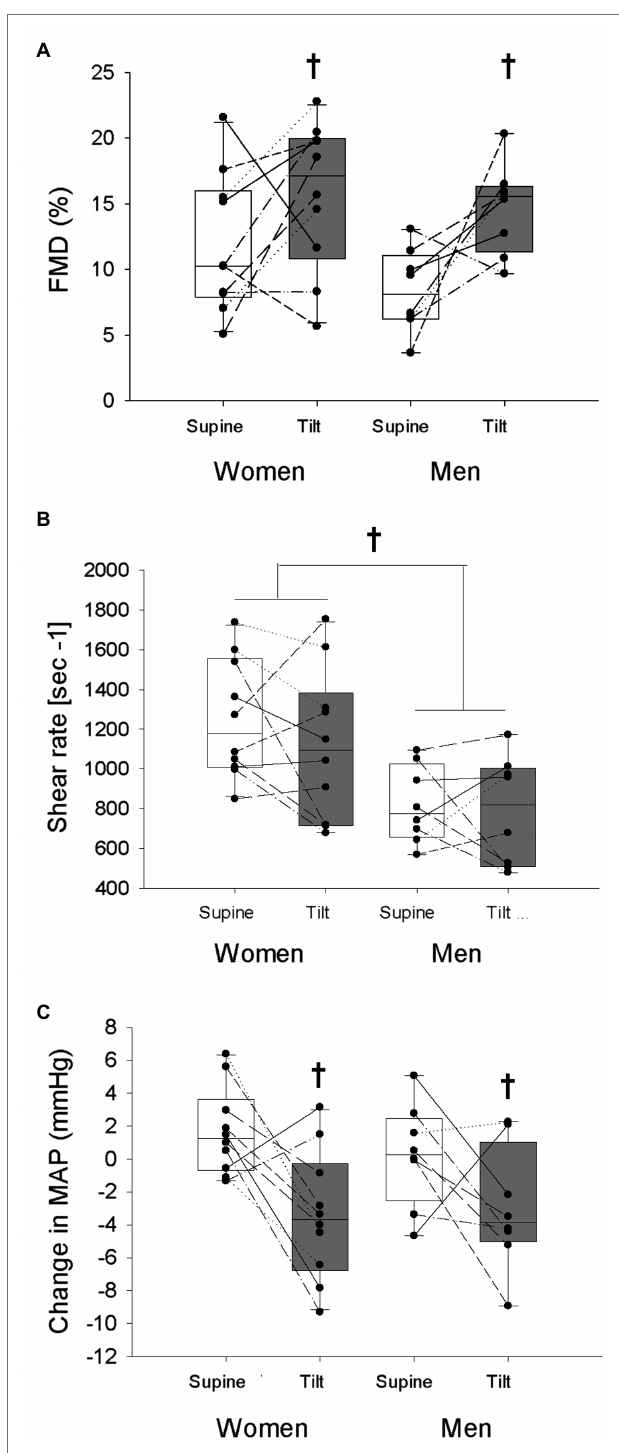
FIGURE 2 | Flow-mediated dilation (FMD; A ), maximal shear rate (B) , and the change in mean arterial pressure (MAP) from the beginning of each trial to the time of maximal brachial artery diameter response (C) is shown in women and men in the supine and tilted postures. White bars indicate supine posture, grey bars indicate upright posture. † indicates a main effect of posture ( p < 0.05). *Indicates a main effect of sex ( p <